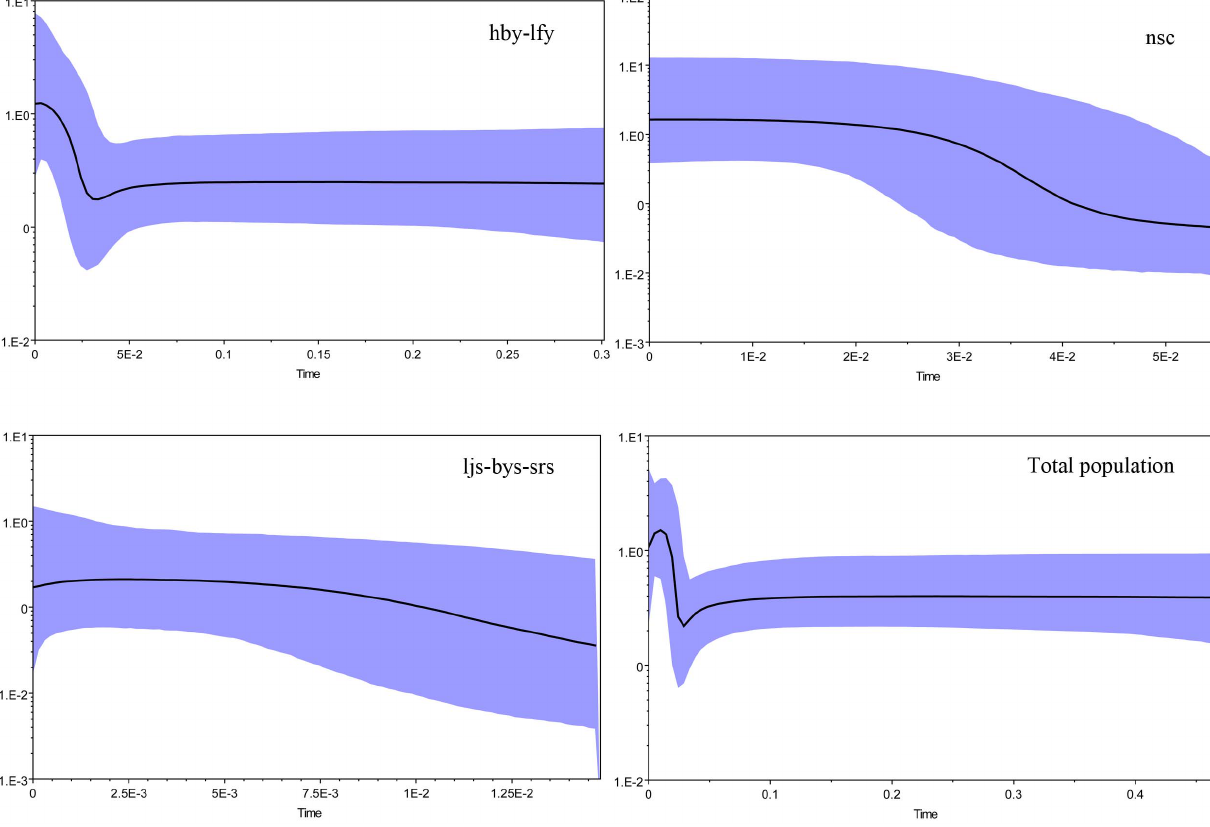
Figure 7. Demographic patterns of each clade and the total population as determined from the Bayesian skyline plot (BSP). The X- axis is in units of million years in the past and the Y-axis is N e * m (effective population size 6 mutation rate per site per generation). The median estimates for the log10 of the population size are shown as thick solid lines, and the 95% highest posterior density (HPD) limits are shown by the shaded areas.